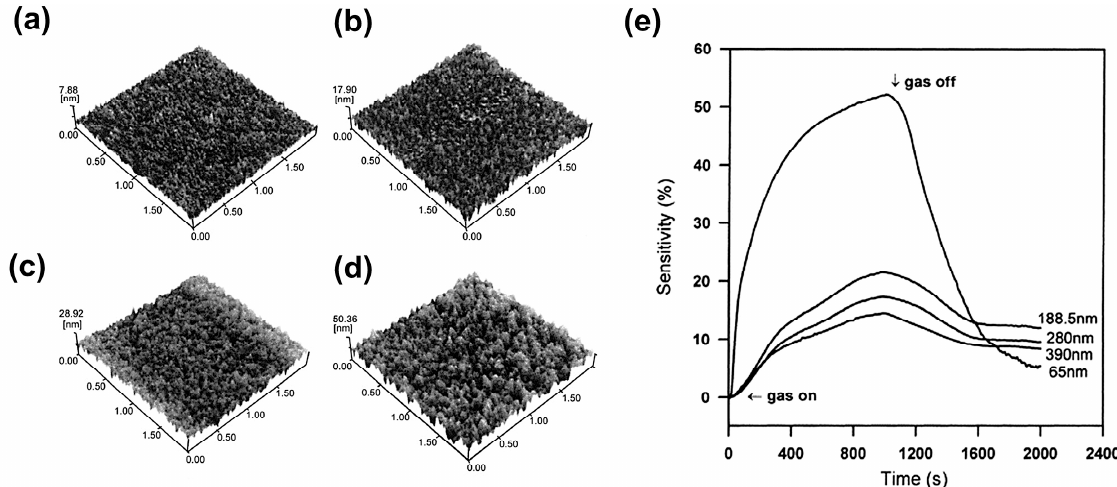
Figure 2. AFM micrographs (2 μ m × 2 μ m) of the as-deposited AZO films with various thicknesses: ( a ) 65 nm, ( b ) 188.5 nm, ( c ) 280 nm, and ( d ) 390 nm, ( e ) the effect of film thickness on the dynamic response toward 1000 ppm CO at 300 °C. Reprinted with permission from Ref. [27]. Copyright 2002, Elsevier.